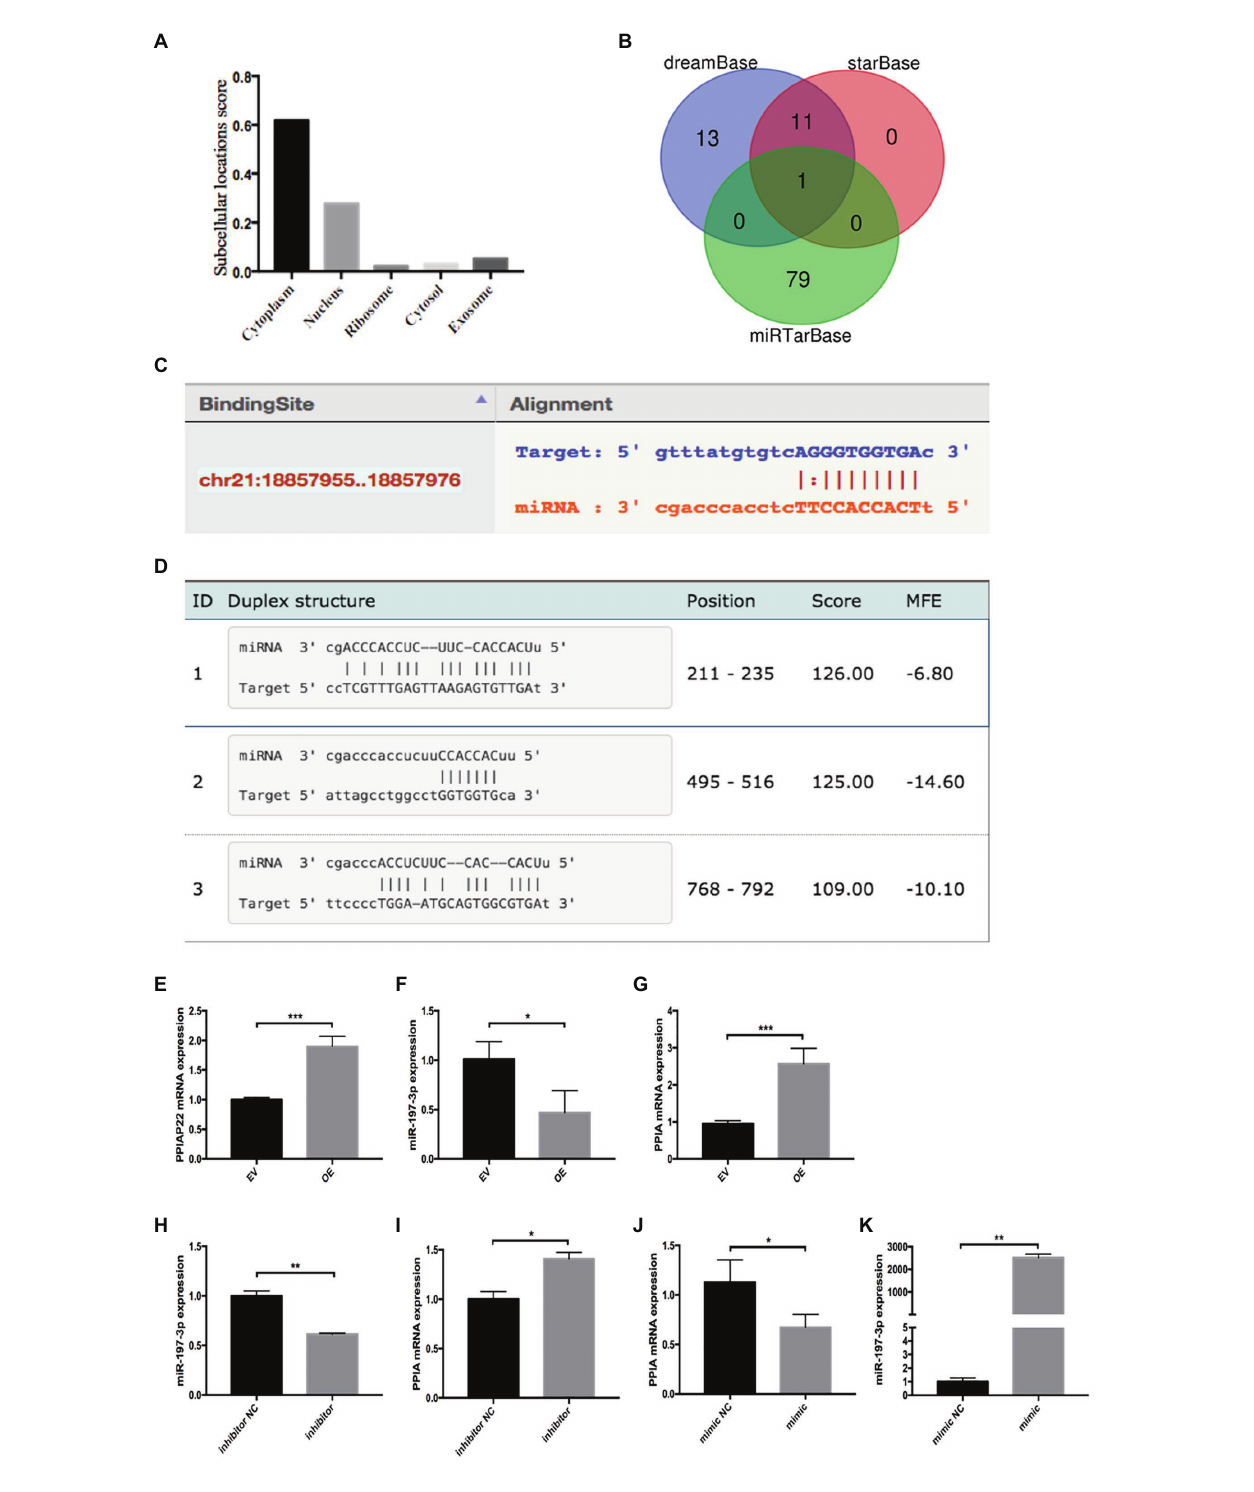
FIGURE 4 | Peptidylprolyl isomerase A pseudogene 22 may function as competing endogenous RNA (ceRNA) competing with PPIA for miR-197-3p binding. (A) Cell localization of PPIAP22 predictied by lncLocator. (B) Bioinformatics analysis of PPIAP22 and PPIA candidate microRNAs (miRNAs). (C) Binding sites between miR-197-3p and PPIAP22 predicted by dreamBase. (D) Binding sites between miR-197-3p and PPIA predicted by miRanda. (E) Overexpression of PPIAP22